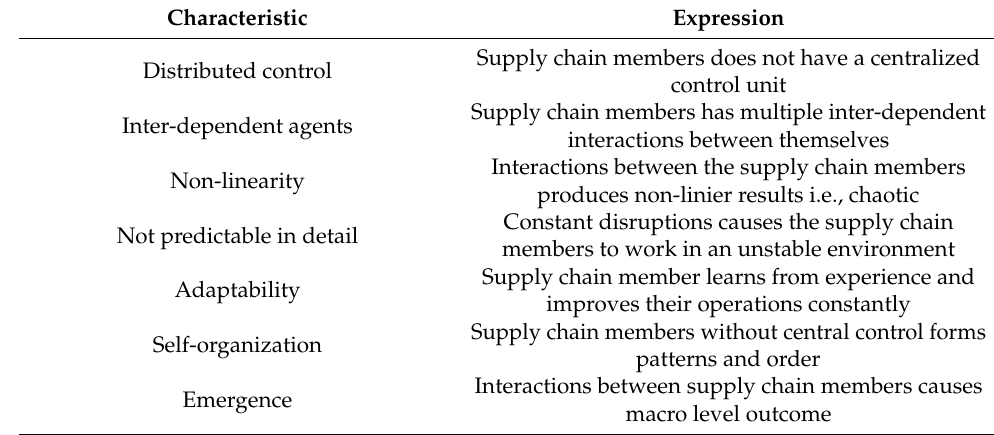
Table 1. Characteristics of Complex Adaptive System in Supply Chain Context, created by authors. Characteristic Expression Supply chain members does not have a centralized Distributed control control unit